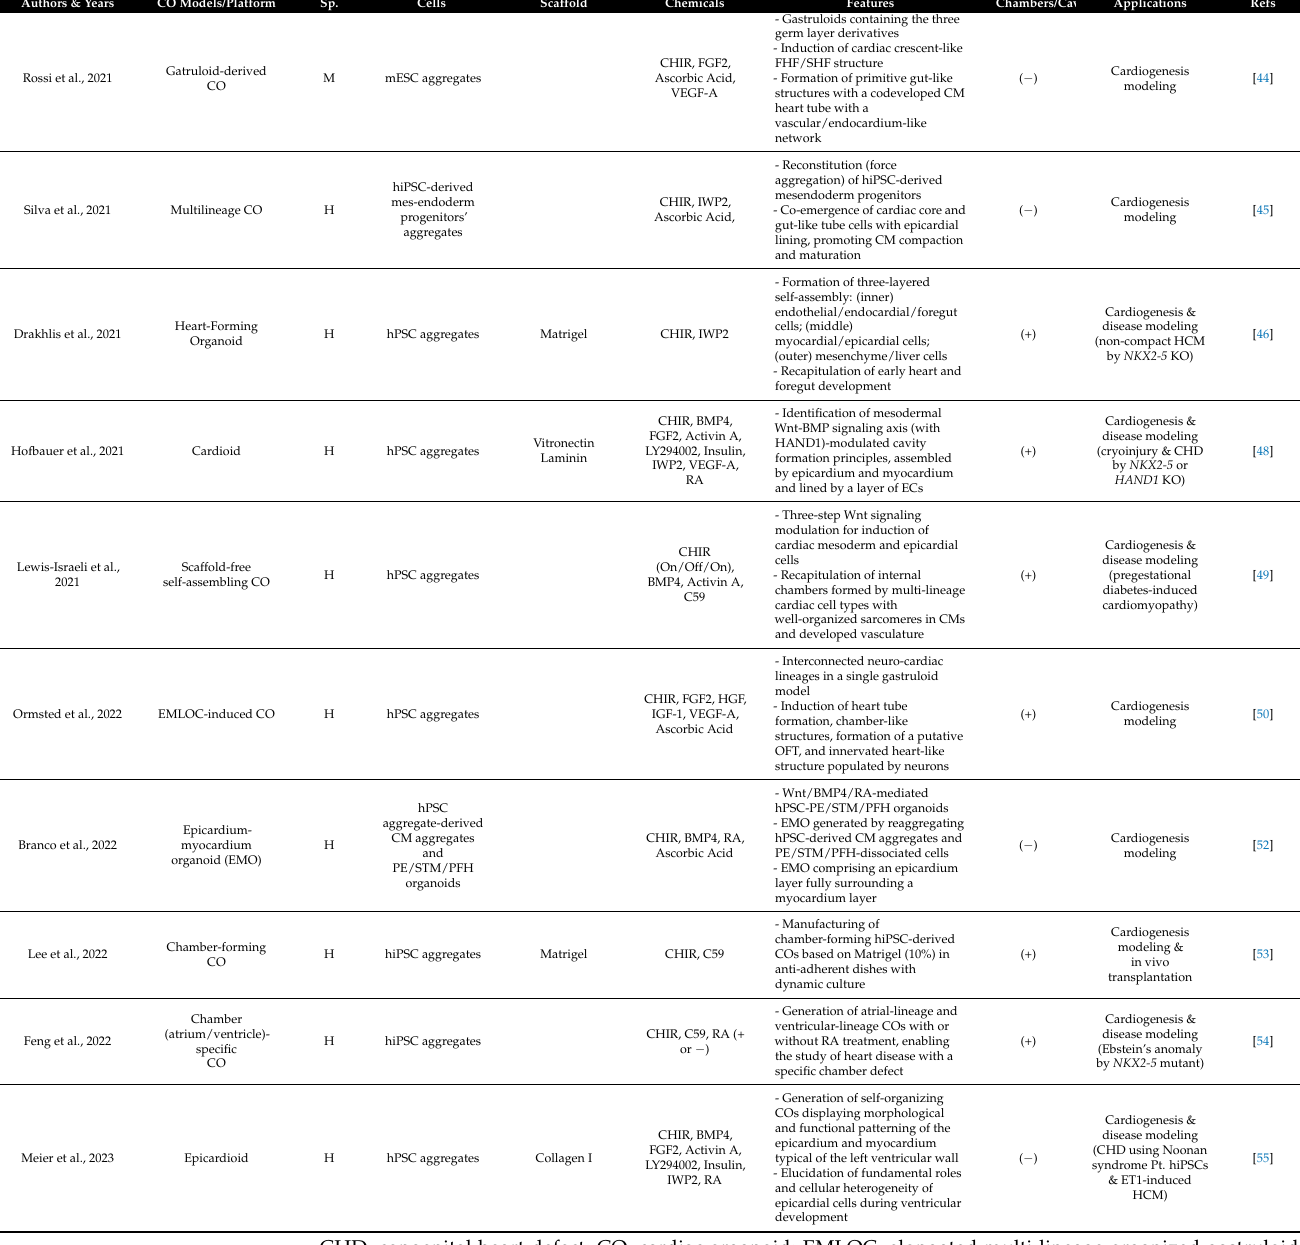
Table 2. Overview of the latest cardiac organoid models since